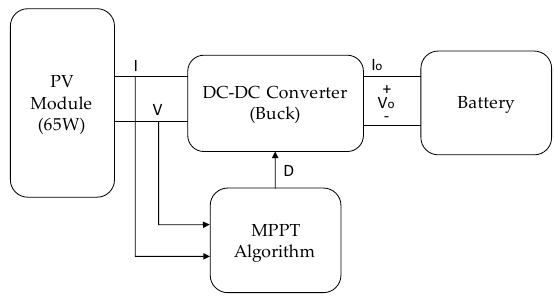
Figure 1. Block diagram of the photovoltaic (PV) system.